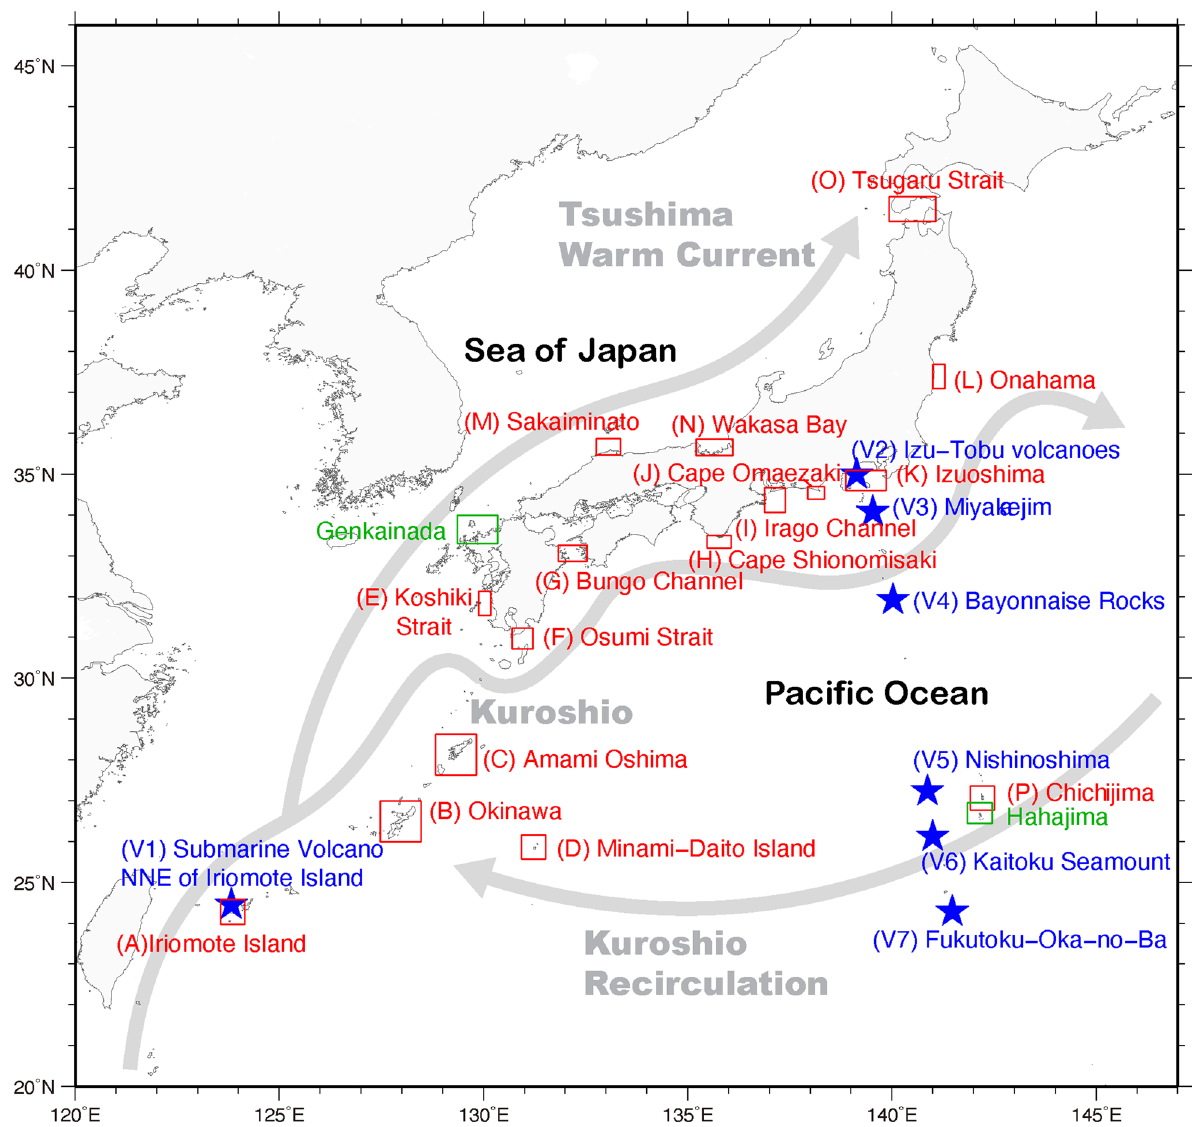
Fig. 1 Submarine volcano and volcanic island sources (blue stars) and target areas (red squares) used in our particle tracking simulations. Green squares are target areas that were only used in our simulation of the 1986 Fukutoku-Oka-no-Ba pumice raft. Major ocean currents around Japan are also